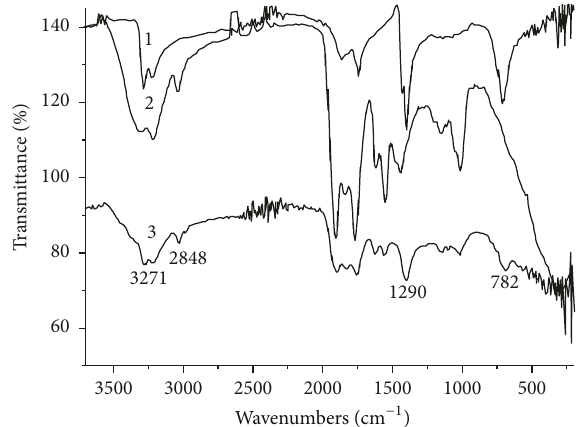
Figure 2: FTIR spectra for systems: 1: cisplatin, 2: D70-g-PAA(PE), and 3: D70-g-PAA(PE)/cisplatin.